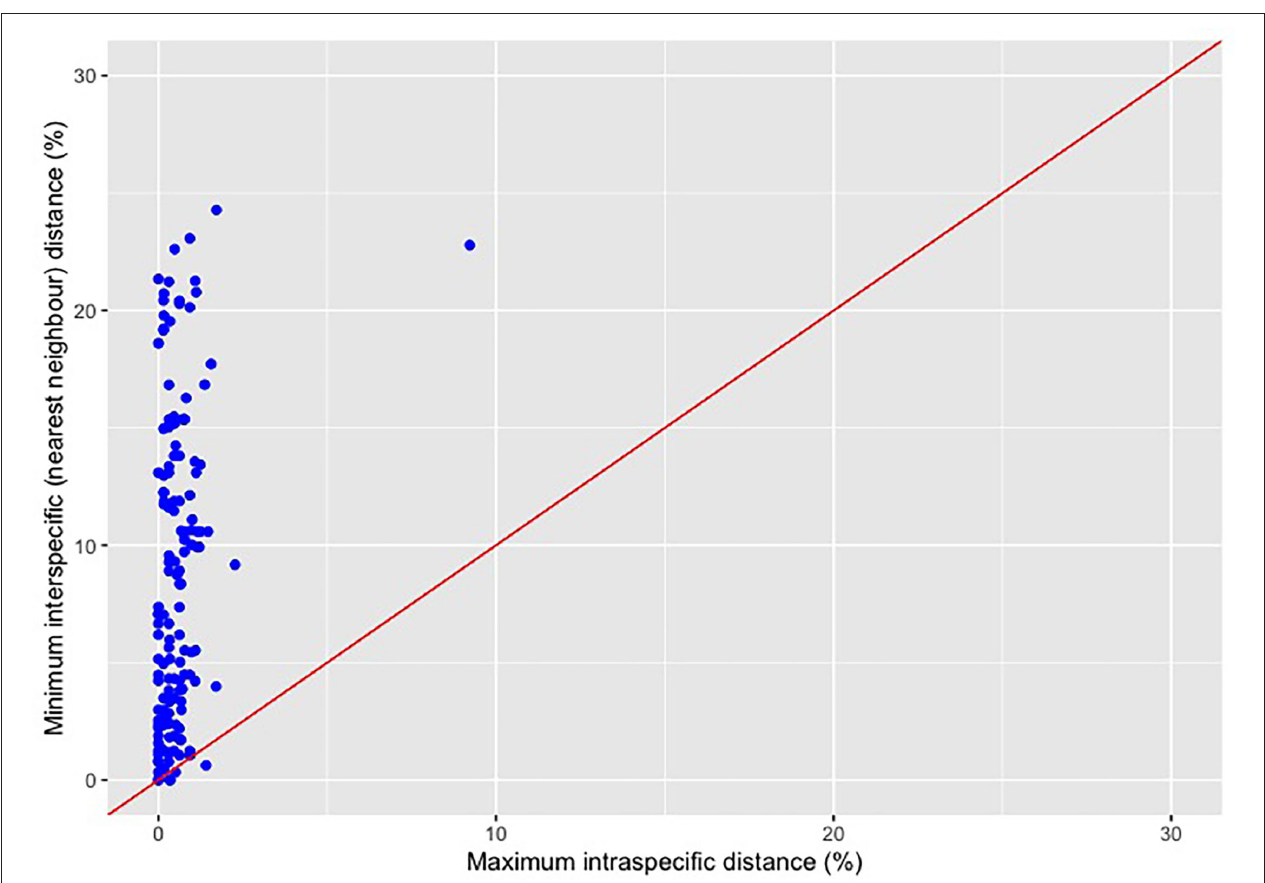
FIGURE 1 | Traditional dotplot for visualizing the DNA barcode gap for a range of Canadian Pacific fishes assessed by Steinke et al. (2009a) and generated using the ggplot2 (Wickham, 2016) R package. Data come from the BOLD Workbench’s Barcode Gap Analysis tool and comprise 1171 specimens from 152 species ( c. 7.7 specimens per species on average). Points lying above the 45 ◦ line indicate that species show a barcode gap and are readily identified via molecular barcodes. On the other hand, points falling below the 1:1 line suggest that species lack a barcoding gap and thus are not easily diagnosed through their DNA barcodes. Most species assessed here [146 of 152 species (96.1%)] display a barcode gap since the minimum interspecific genetic distance exceeds the maximum intra-specific genetic distance. Despite this, evidence of species showing a barcode gap may in fact be an artifact of limited sampling of within-species haplotype variation. The species Cyclothone atraria at the point (9.22, 22.78) is clearly visible as an extreme outlier and signals possible cryptic species